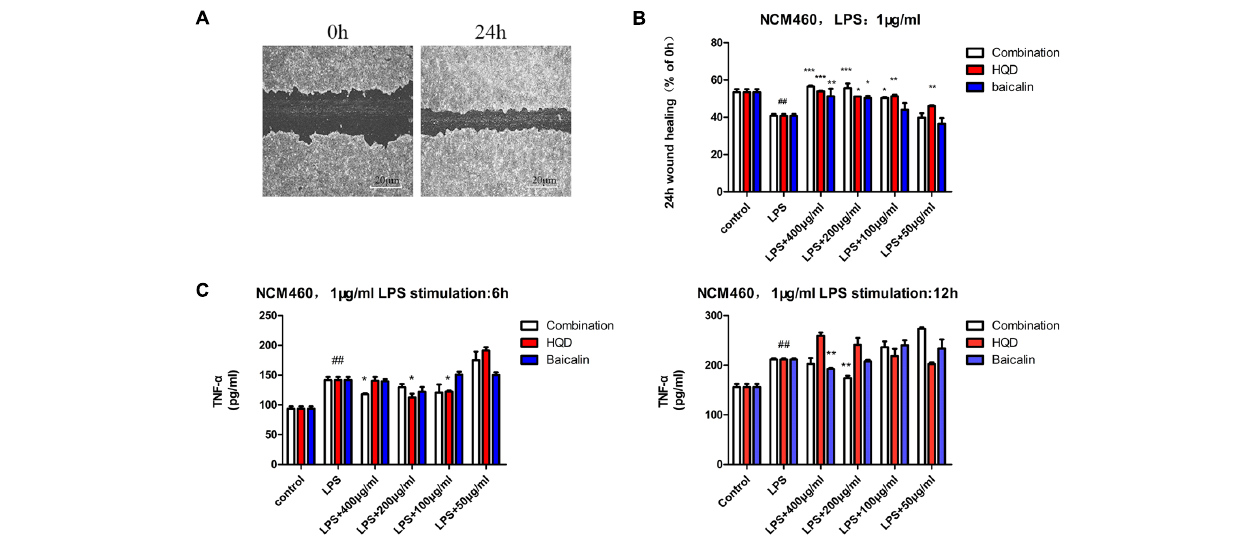
FIGURE 3 | Activity assays of HQD, components combination and baicalin in NCM460. (A) Phase contrast microscopy images of two migrating epithelial monolayers of NCM460. (B) NCM460 were incubated with vehicle, HQD, the combination and baicalin for 24 h, following cell scratch and 24 h stimulation of LPS. 24 h wound healing was determined as % of 0 h. (C) NCM460 were pretreated with vehicle, HQD, the combination and baicalin for 12 h, following 6 or 12 h stimulation of LPS, the accumulated TNF- α in the culture medium were measured using commercial ELISA kits. Results are expressed as mean ± SD of at least three independent experiments. ## P < 0.01 versus control group, ∗ P < 005, ∗∗ P < 0.01, ∗∗∗ P < 0.001 versus model group (One-way analysis of variance with Dunnett’s post hoc test).